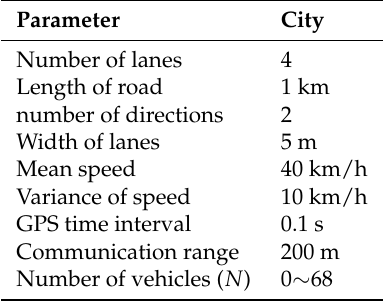
Table 2. Moving parameters of highway scene.